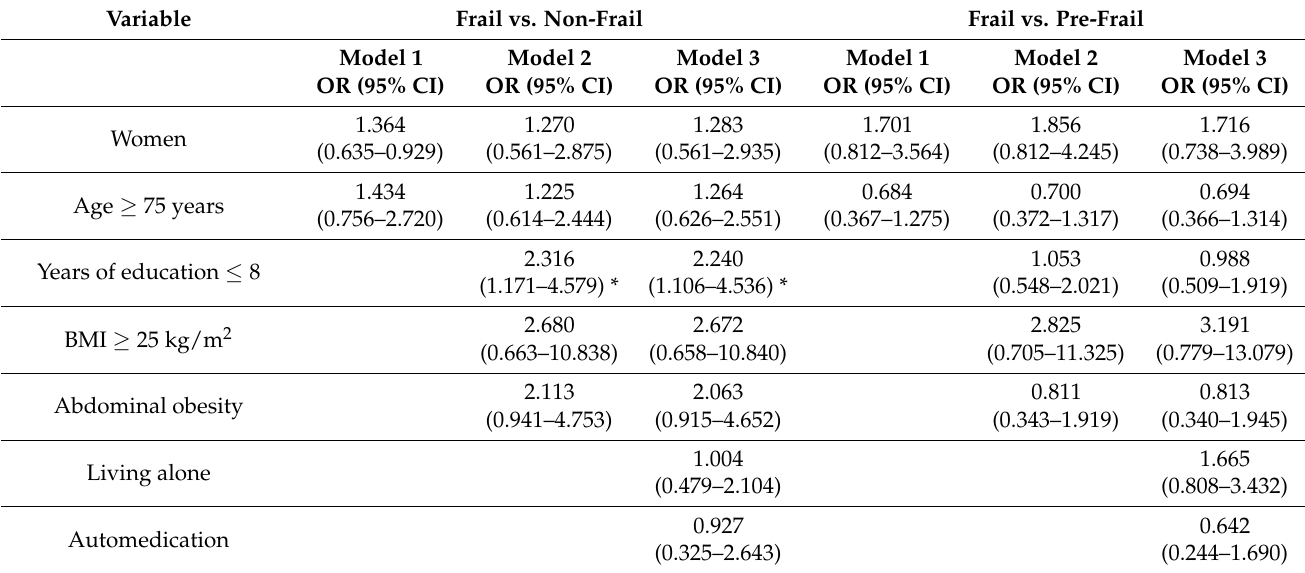
Table 4. Logistic regression for the association of frailty according to FP as a dependent variable with variables of relevance in health, adjusted by age and sex.